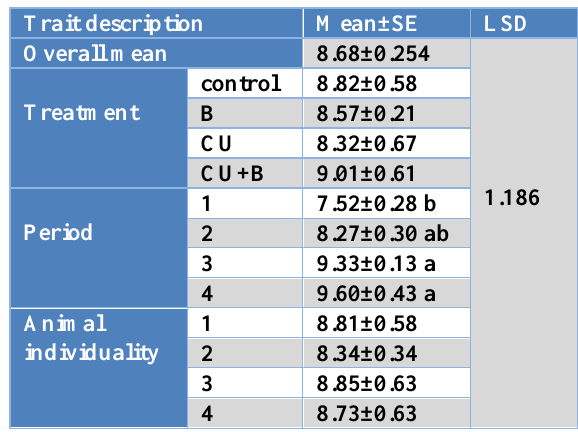
Table, 4: Effect of using Ocimum basilicum and/or Cuminum cyminum on rumen NH 3˗ N (mg/dl) during different period and Awassi ram